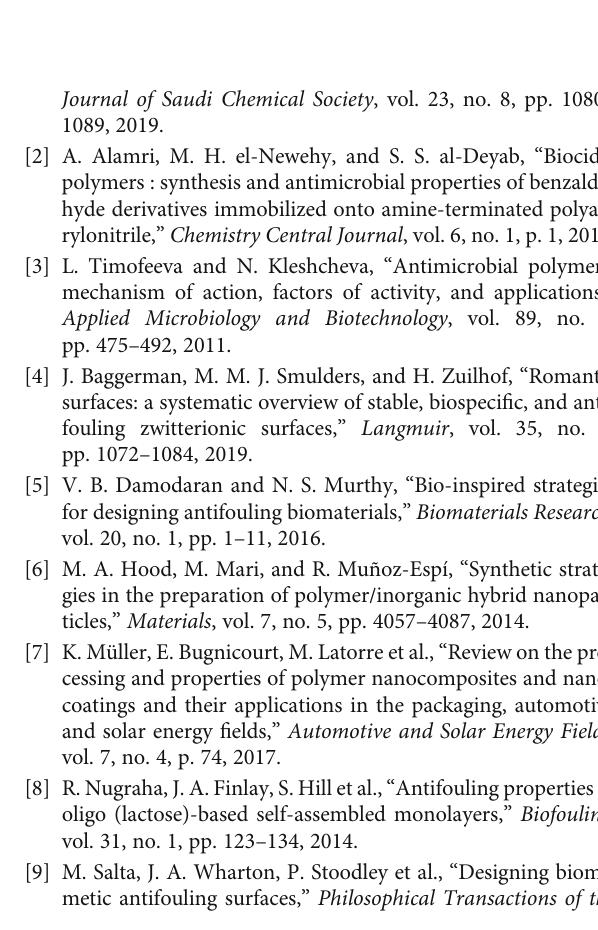
Figure 10: Optical microscopy of algal bio fi lm of Dictyosphaerium for the various copolymers of P(SPMA-co-MMA): (a) PSM50, (b) PSM40, (c) PSM30, and (d)